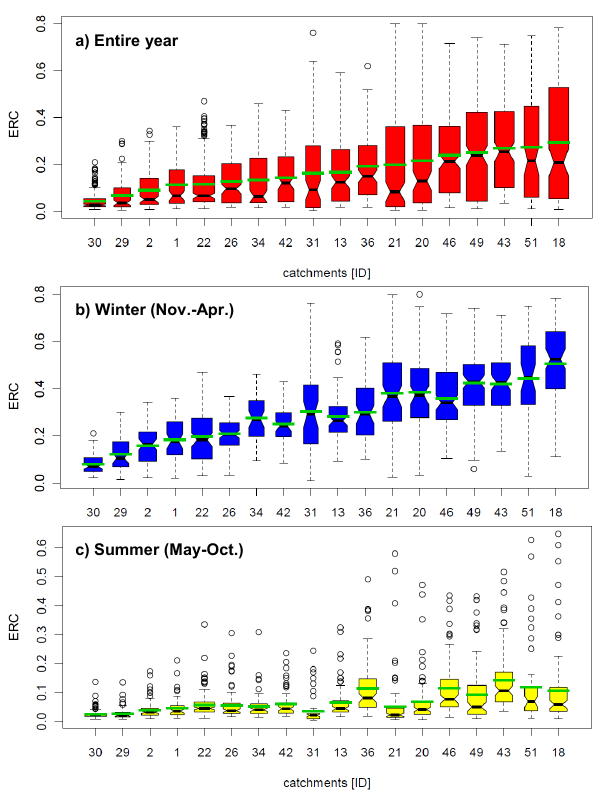
Fig. 2. Boxplots of ERC for 18 catchments for (a) the entire year, (b) winter and (c) summer. The boxplots show the 25th and 75th percentile, the median, values inside the interquartile range from the box and outliers of the event runoff coefficients. The green lines indicate the mean ERC. The widths of the boxes are propor- tional to the square-roots of the number of ERCs for this catchment.